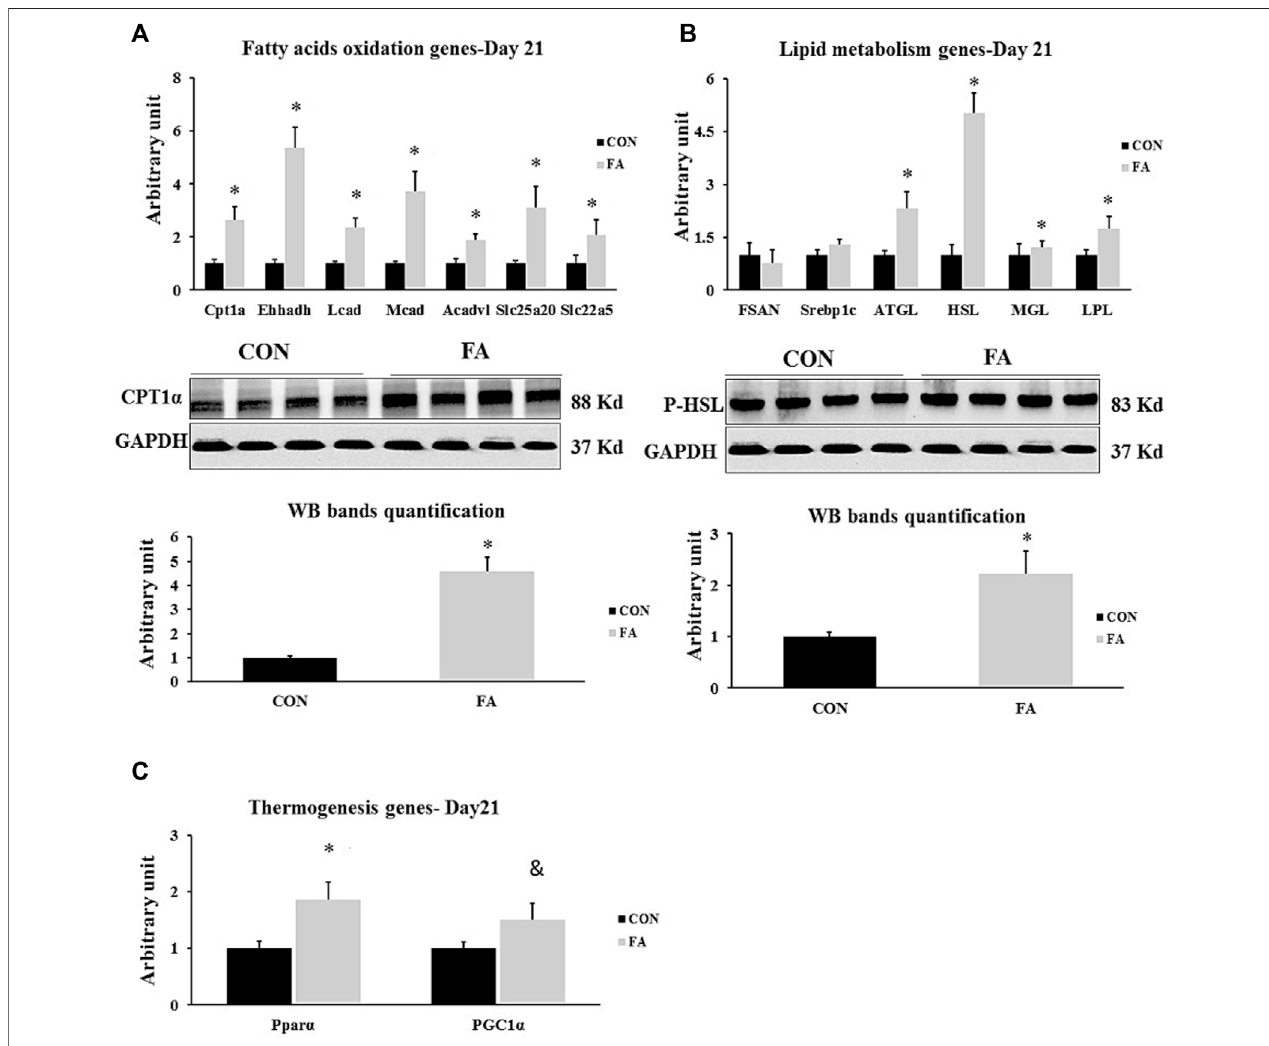
FIGURE 10 | Effect of maternal intake of EPA/DHA on hepatic genes regulating lipid metabolism in weaned mice (D21). The mothers were fed either control diet (CON) or EPA/DHA enriched diet (FA) during the entire period of pregnancy and lactation (A) Quantitative RT-qPCR ( n = 8) and representative image and densitometric analysis of western blot ( n = 4) of genes regulating fatty acid uptake and a β -oxidation in neonates in weaned mice (D21) (B) Quantitative RT-qPCR ( n = 8) and representative image and densitometric analysis of western blot ( n = 4) of genes involved in regulating lipogenesis and lipolysis in weaned mice (D21). (C) Quantitative real-time PCR ( n = 8) analysis of the expression of genes regulating the thermogenesis process in weaned mice (D21). The control image of GAPDH from liver sample (D21) was reused in panel B and (C) . The raw Ct was normalized to the value of 18 s. All data represent as mean ± SEM. p < 0.05 by Student ’ s t-test.